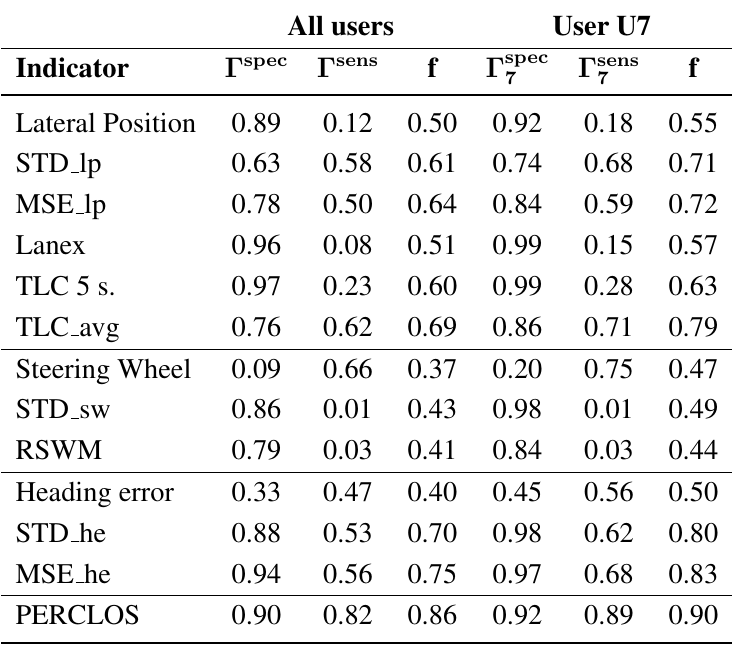
Table 4. Indicators without optimization (simulation).